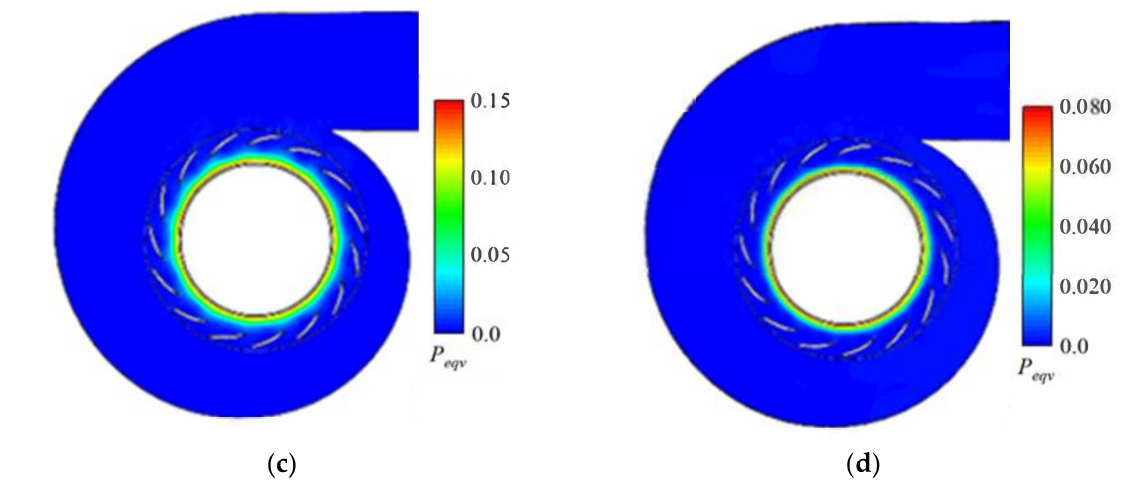
Figure 15. P eqv amplitude contour of typical frequencies on Z = 0 plane. ( a ) 140 Hz; ( b ) 280 Hz; ( c ) 420 Hz; ( d ) 560 Hz.